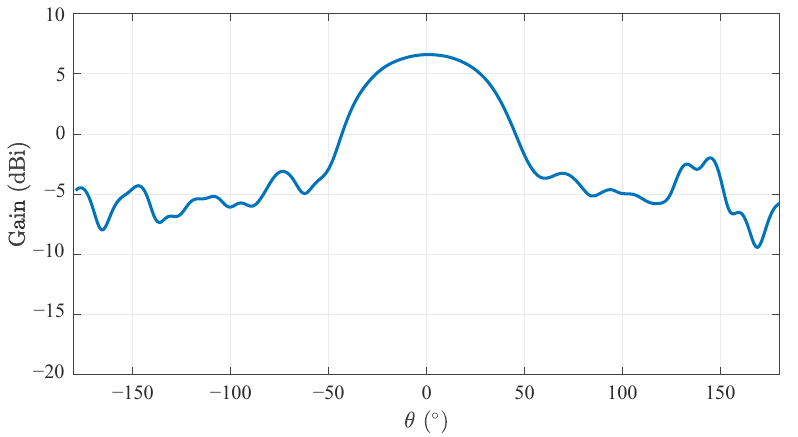
Figure 13. Measured antenna pattern averaged over the frequency range of 8...12GHz and Φ =